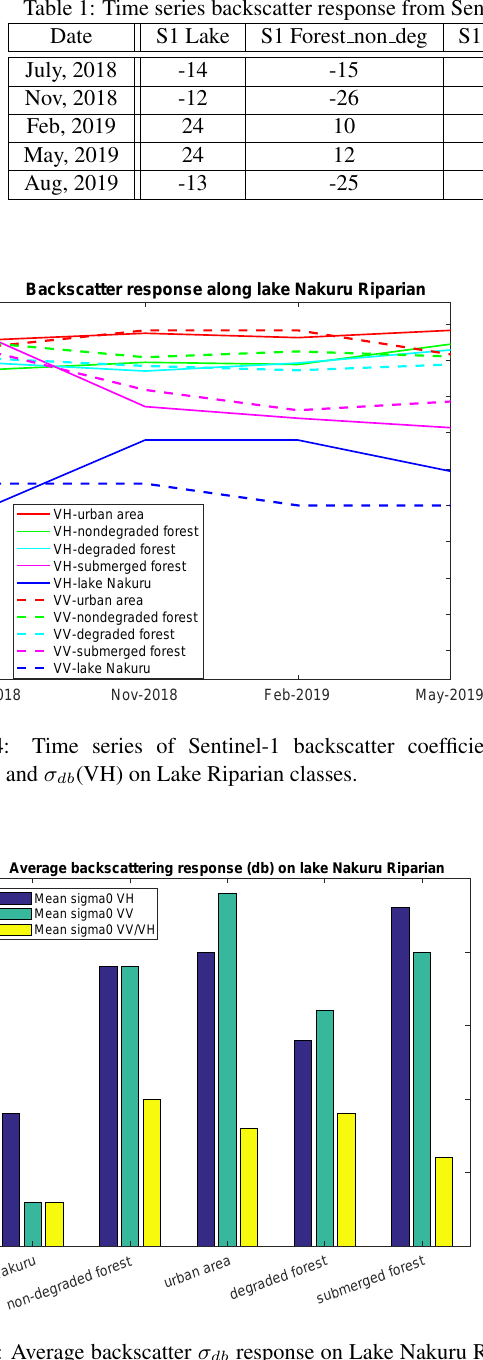
Figure 5: Average backscatter σ db response on Lake Nakuru Ri- parian classes.